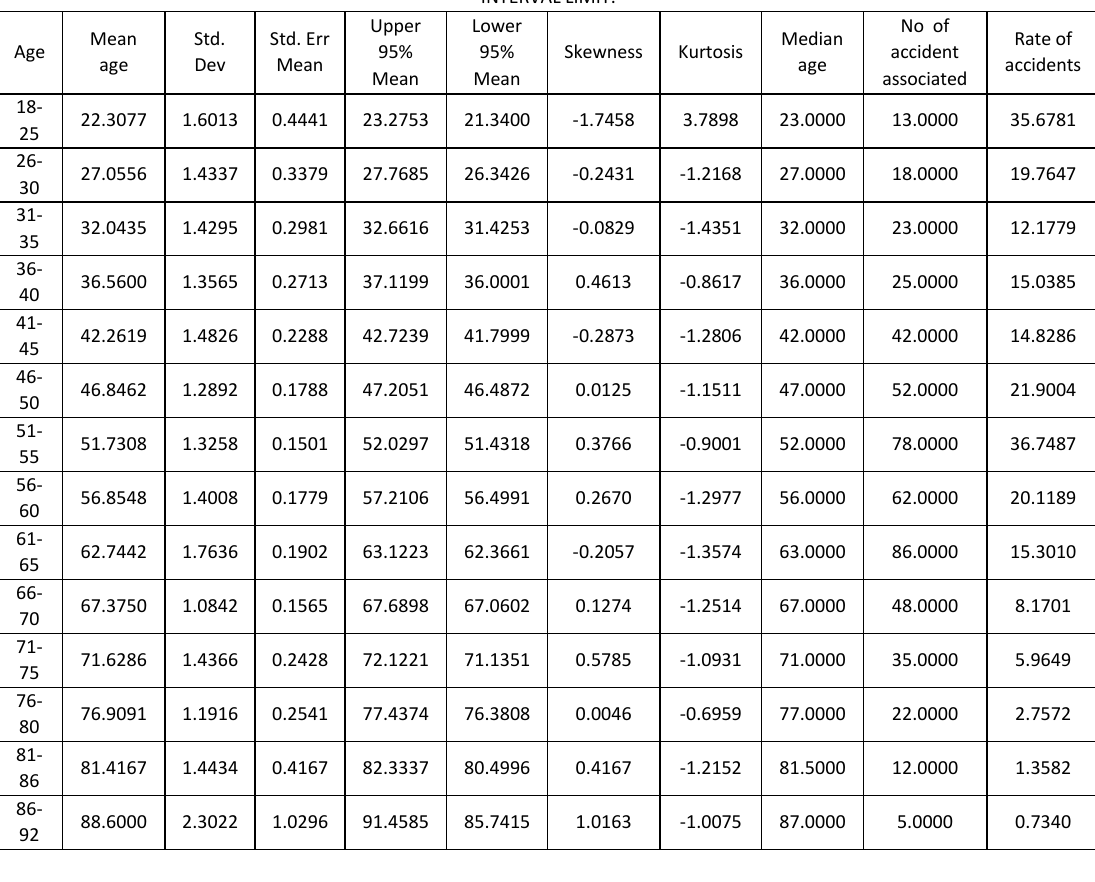
TABLE A1: DESCRIPTIVE STATISTICS SUMMERY: ASSOCIATED NUMBER OF ACCIDENTS WITH MEAN AGE WITHIN 5 YEARS OF INTERVAL LIMIT.